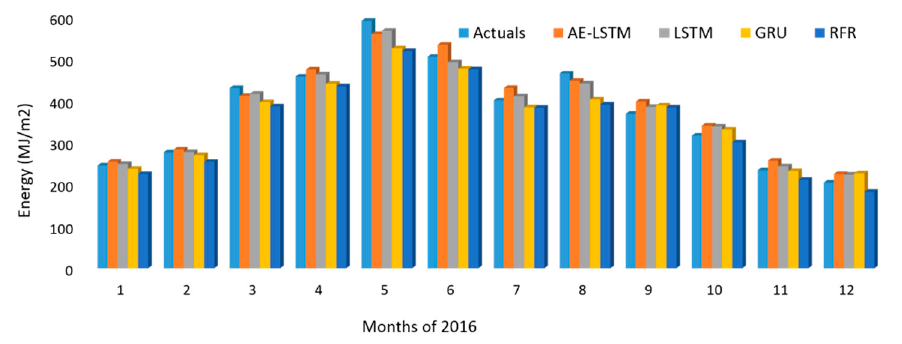
Figure 14. PV energy potential estimation for the year 2016.